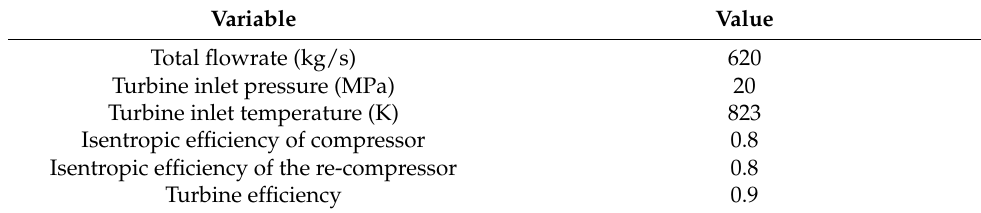
Table 1. Specifications used for the recompression s-CO 2 Brayton cycle.